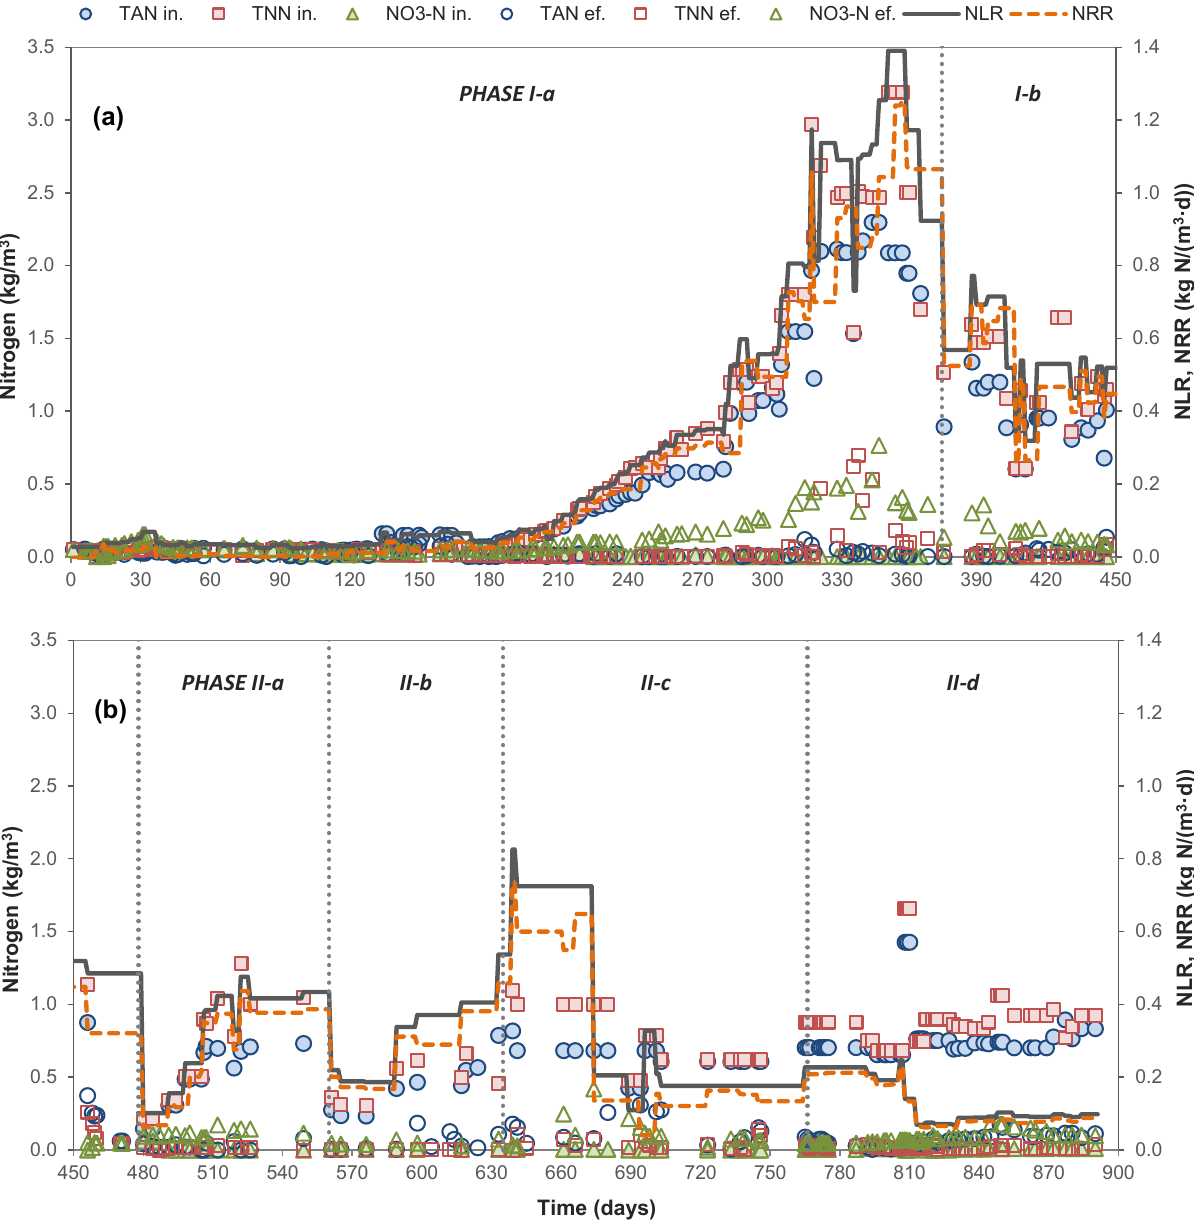
Figure 4. Performance of the pilot-scale A-SBR; ( a ) PHASE I : Start-up and enrichment with synthetic wastewater; ( I-a ) influent with increasing N content; ( I-b ) influent with N content similar to that in the PN-SBR effluent and preliminary tests partially adding nitritated leachate; ( b ) PHASE II : adaptation to landfill leachate and routinary operation; ( II-a ) influent with 25% to 50% of leachate treated in PN-SBR; ( II-b ) influent with 50% to 100% of leachate treated in PN-SBR; ( II-c ) coupling of PN-SBR with A-SBR treating raw leachate; ( II-d ) operation with raw leachate once transferred 85% of the MLSS to the full-scale A-SBR.